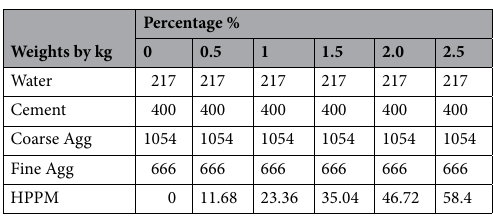
Table 3. Mix proportions of